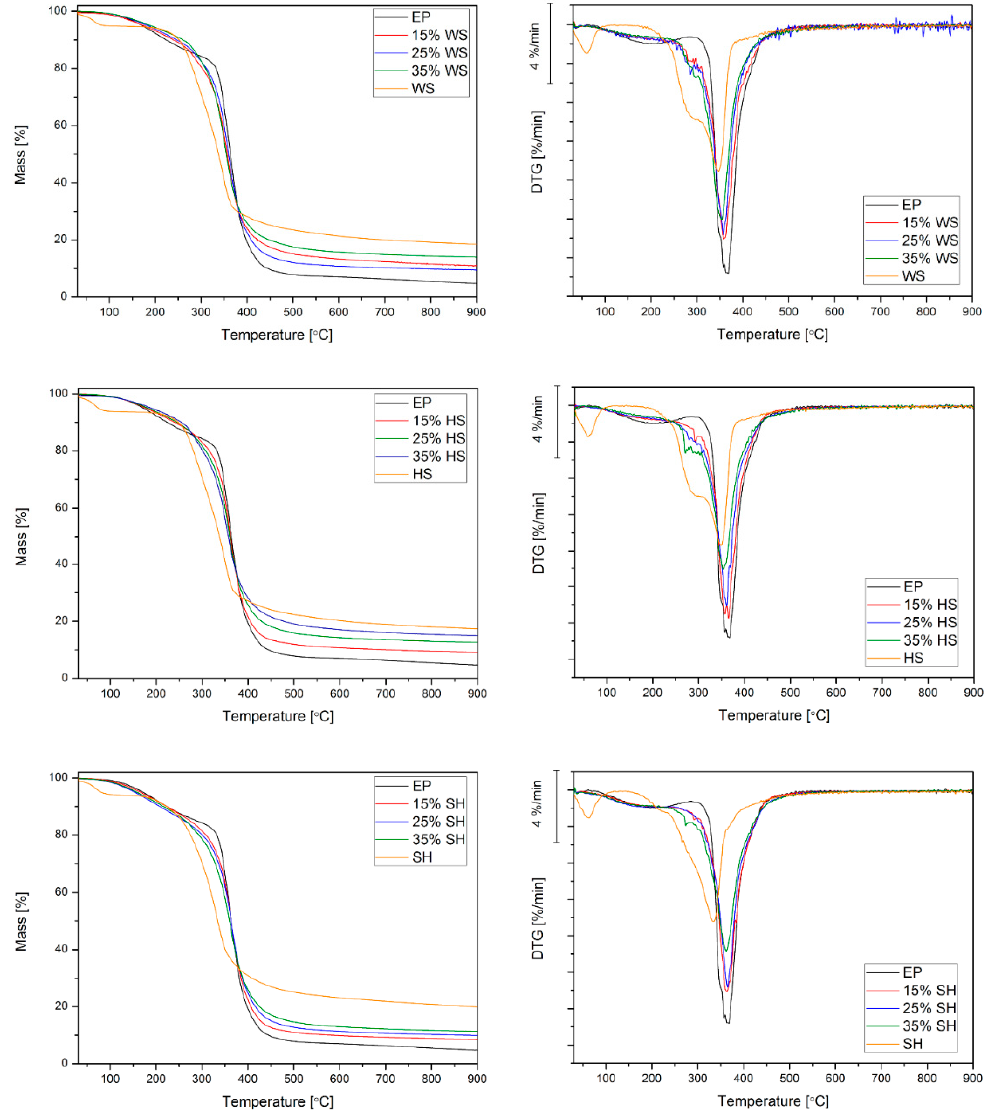
Figure 7. TG and DTG curves of epoxy resin, epoxy composites and natural filler investigated in an inert atmosphere.